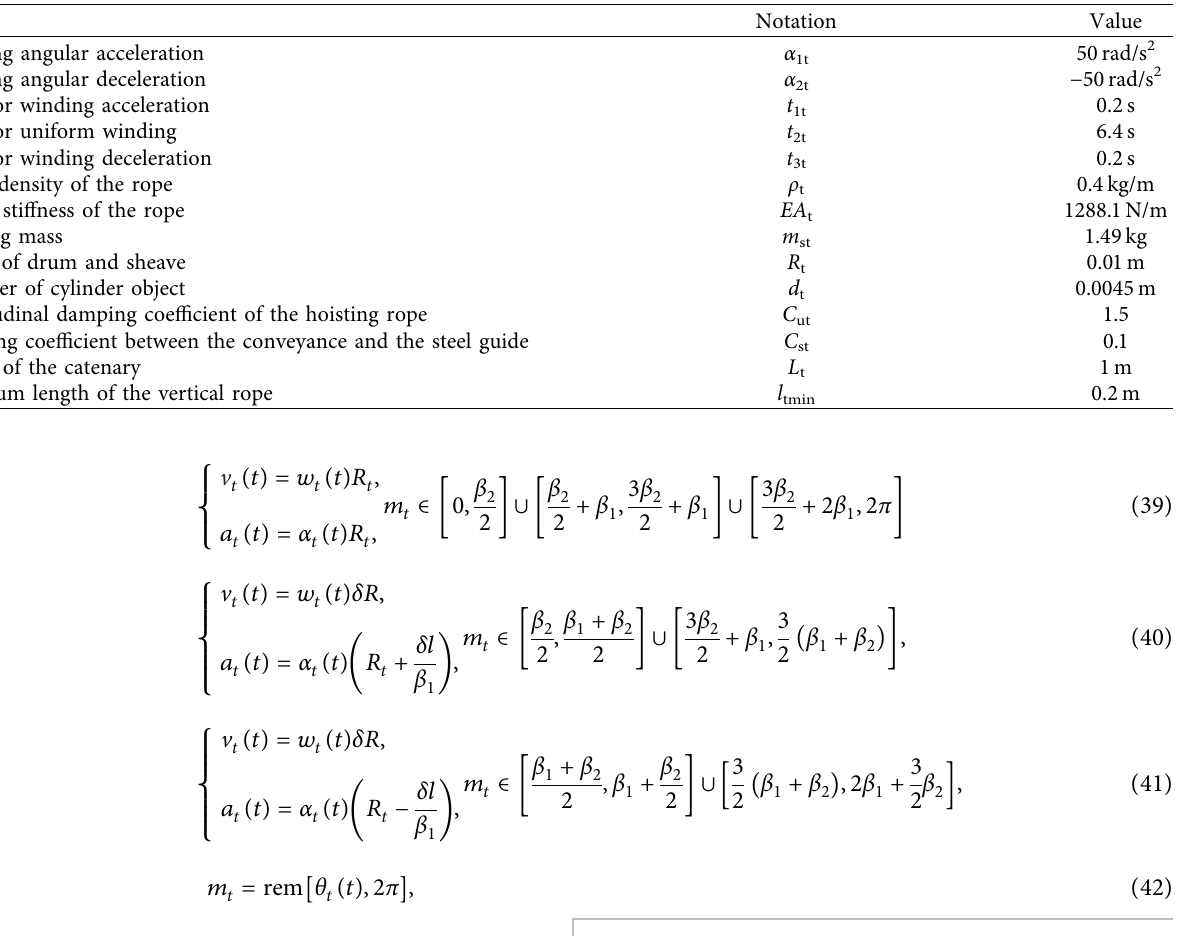
Table 3: Parameters of test